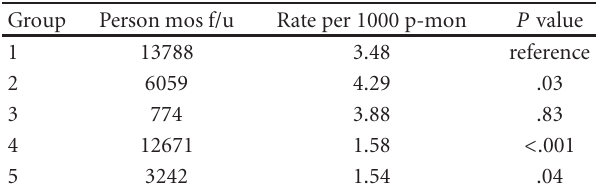
Figure 2: Patient survival by group. It depicts plots and tables of patient survival across the five patient categories represented by failure rates per 1000 person-months